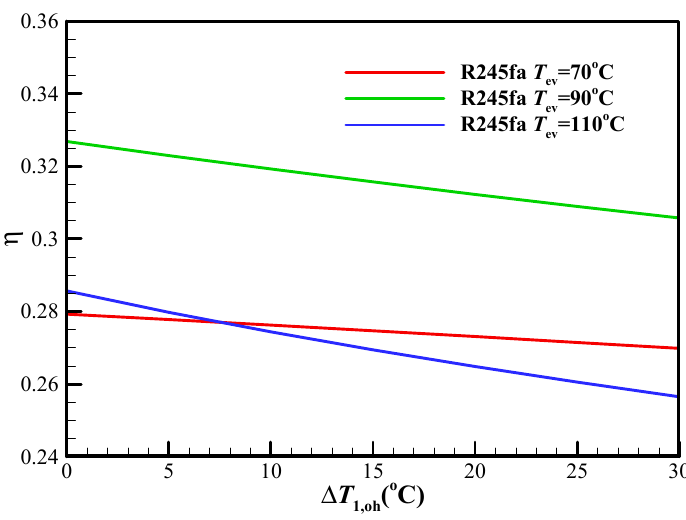
Figure 5. Variation of plant exergy efficiency versus overheating degree.